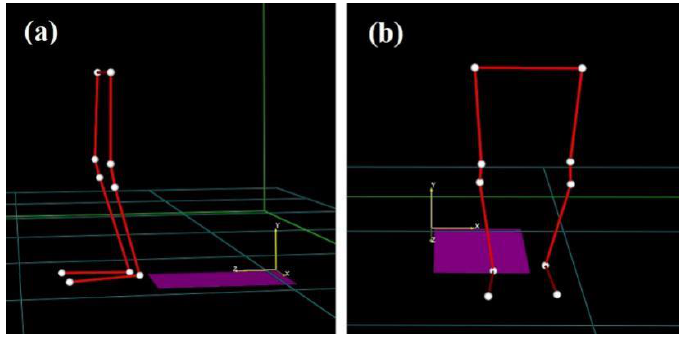
Figure 2. Marker-set protocol for motion capture data acquisition: side view ( a ) and front view ( b ). The markers were placed on the external side of both lower limbs to track the positions of